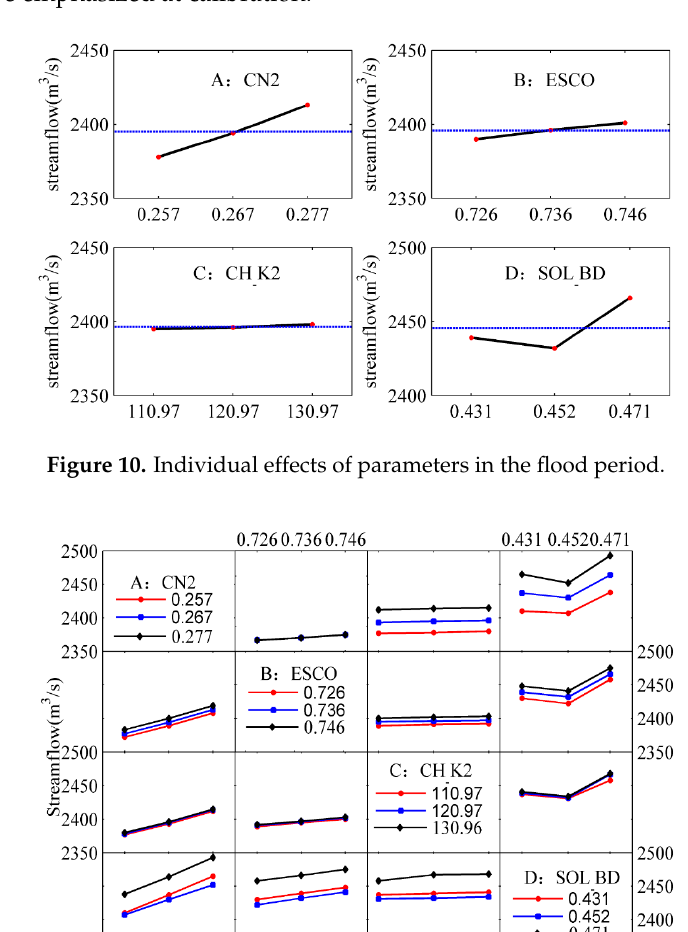
Figure 10. Individual effects of parameters in the flood period.